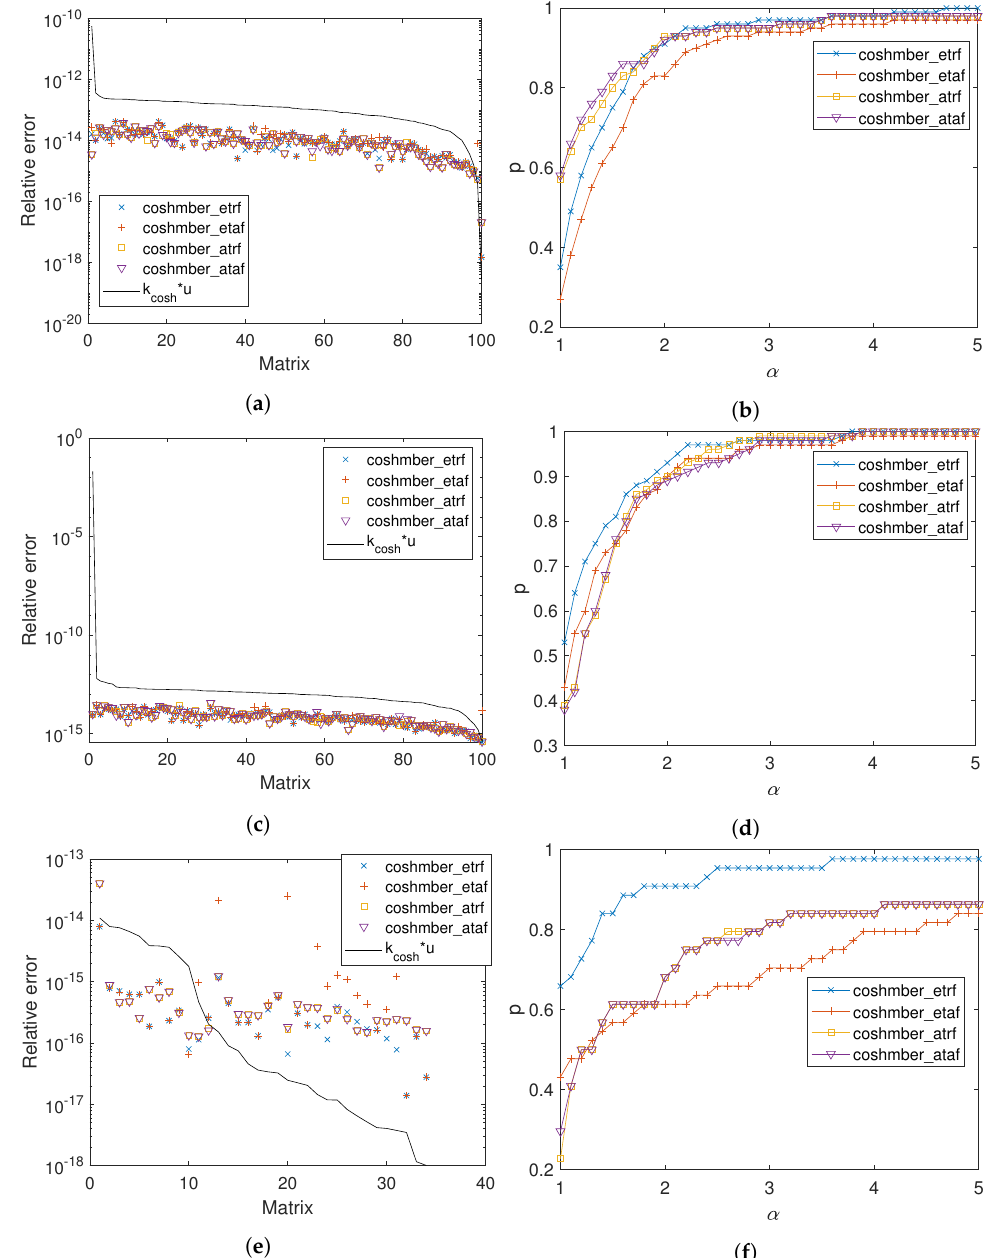
Figure 1. Experiment 1: Normwise relative errors for matrix sets 1 ( a ), 2 ( c ) and 3 ( e ) and performance plots for the same sets ( b , d , f